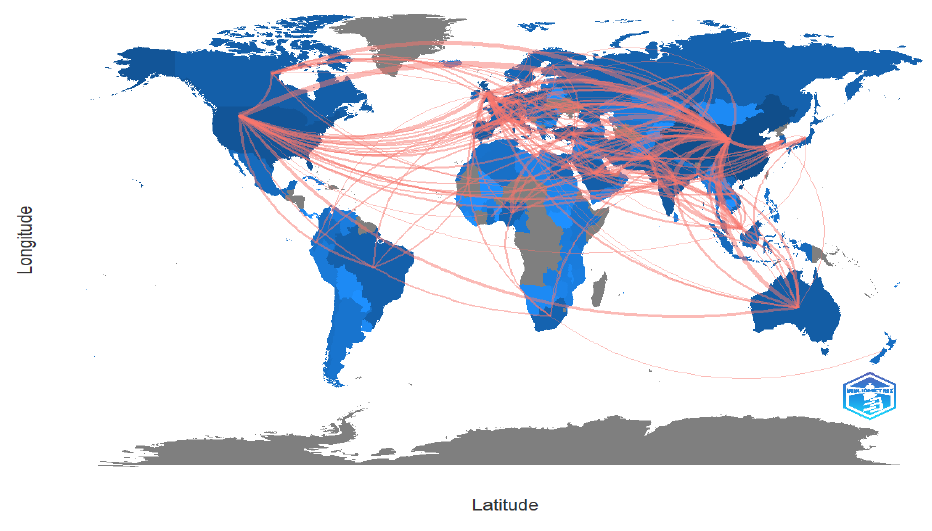
Figure 8. Collaboration world map .